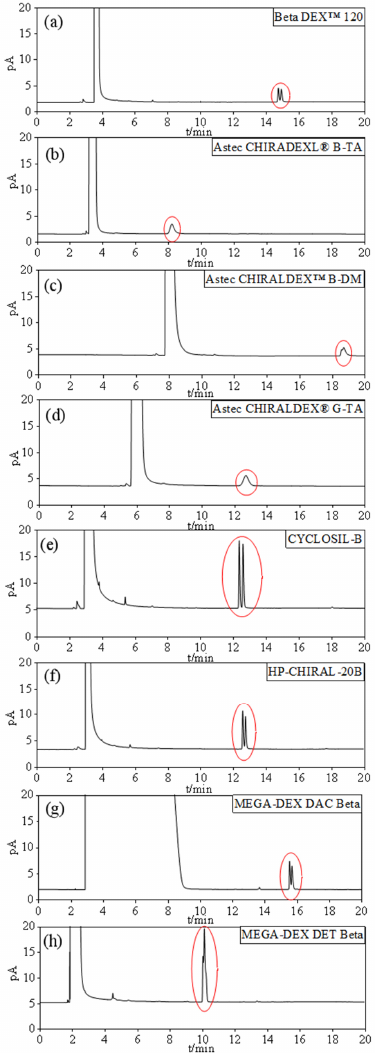
Figure 2. Chromatograms of 2-pentanol racemate separated by different chiral chromatographic columns ( a ): Beta DEX™ 120, ( b ): Astec CHIRADEXL ® B-TA, ( c ): Astec CHIRALDEX™ B-DM, ( d ): Astec CHIRALDEX ® G-TA, ( e ): CYCLOSIL-B, ( f ): HP-CHIRAL-20B, ( g ): MEGA-DEX DAC Beta, ( h ): MEGA- DEX DET